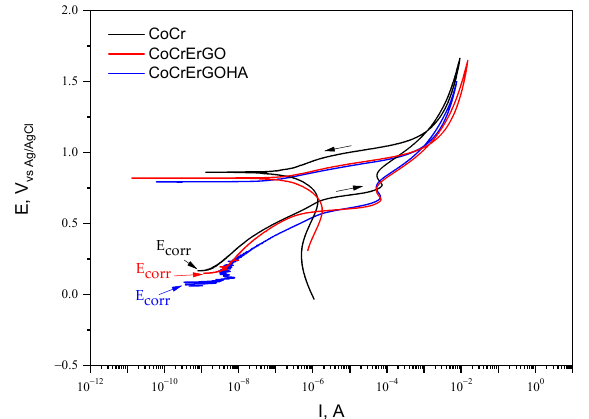
Figure 4. Anodic polarization curves (APC) of CoCrErGOHA, CoCrErGO, and CoCr surfaces in PBS ‐ HA medium.